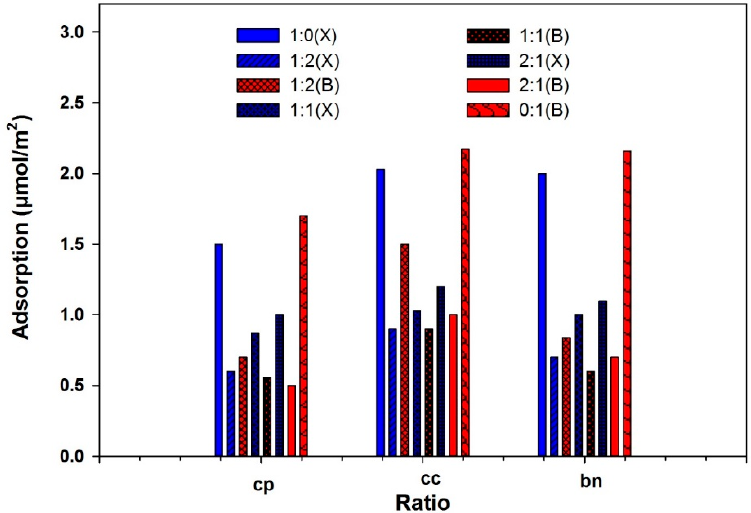
Figure 8. Adsorption of collectors from the mixtures of SIBX(X) and BBT(B) at pH 8.2 and total concentration 3 × 10 − 5 M (SIBX was added first). cp-chalcopyrite, cc-chalcocite, bn-bornite.